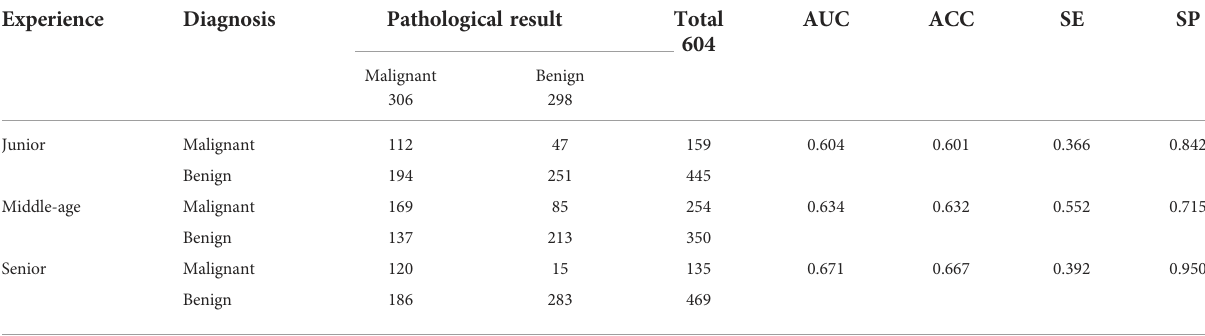
TABLE 5 The subjective results of three